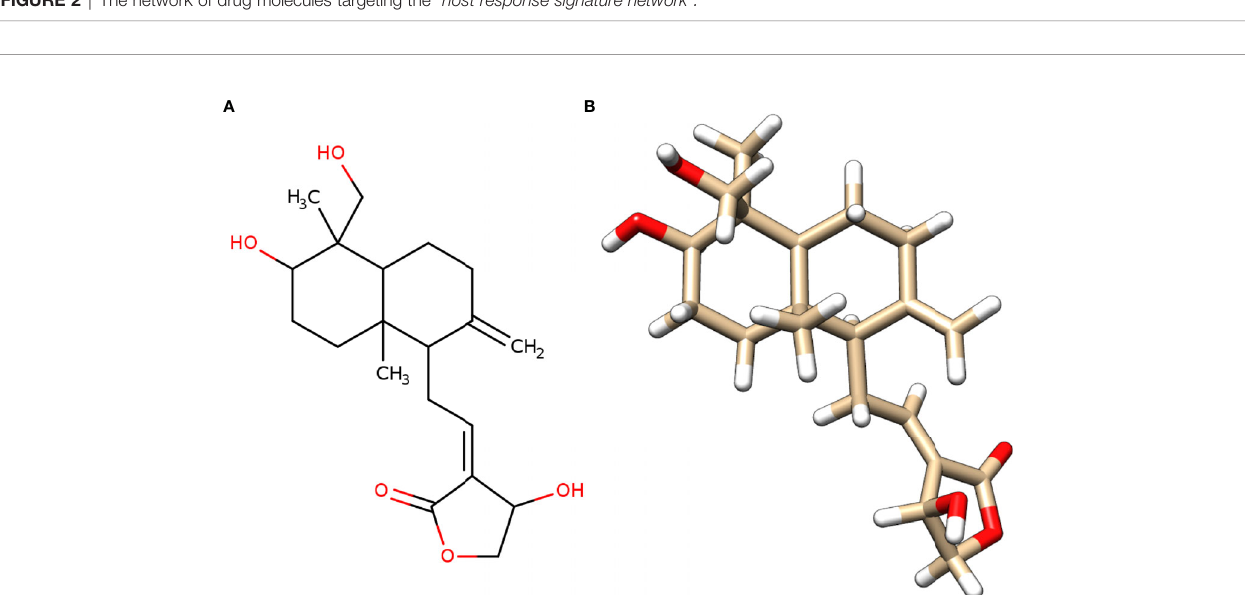
FIGURE 3 | Molecular structure of andrographolide. (A) Two-dimensional sketch of andrographolide with O-atoms and -OH groups in red color. (B) Three- dimensional diagram of andrographolide with O-atoms in red and H-atoms in white colors.